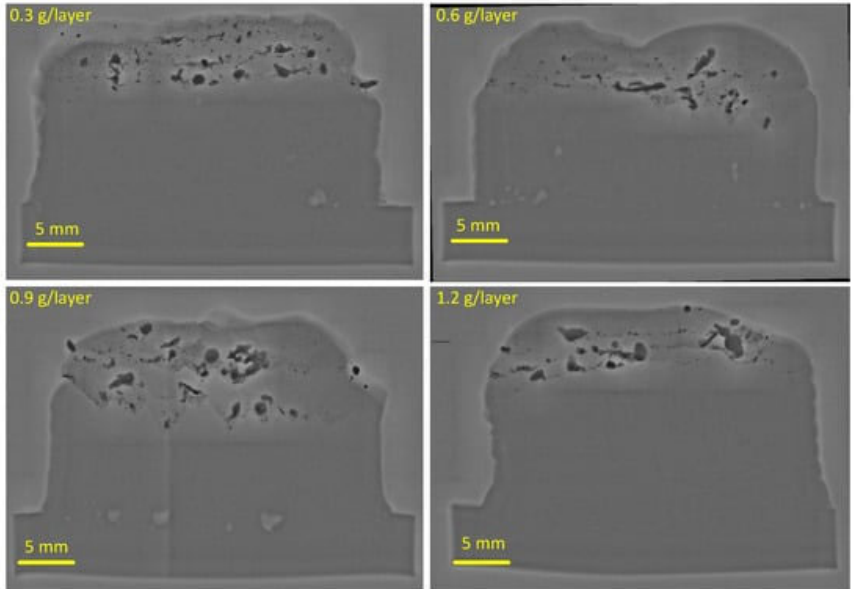
Figure 14. X-ray images of molybdenum powder distribution in the surface layer of AA5056 alu- Figure 14. X ‐ ray images of molybdenum powder distribution in the surface layer of AA5056 alumi ‐ minum alloy [168]. num alloy [168].